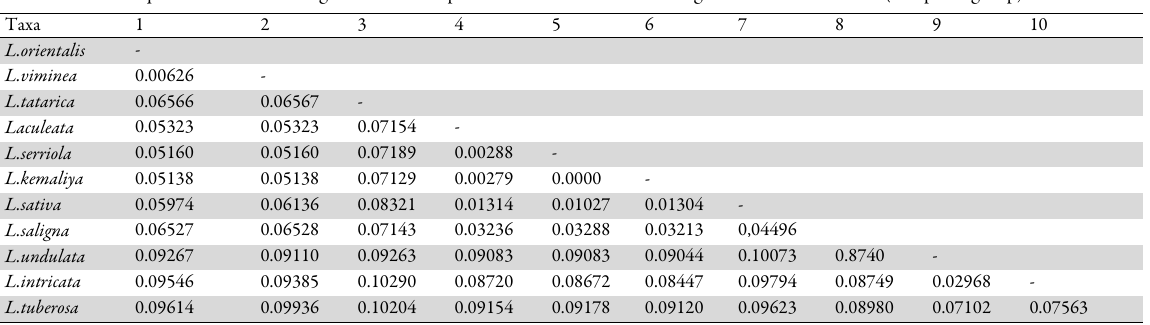
Table 2. Pairwise sequence distances among some Lactuca species for ITS nrDNA data using PAUP distance matrix (except outgroup)